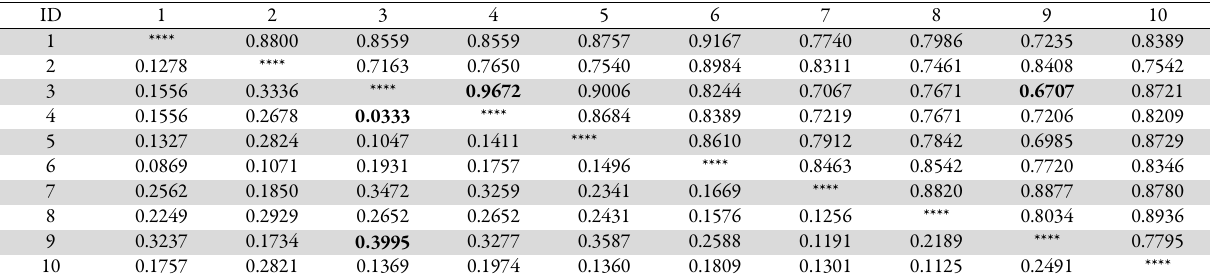
Table 5. Genetic identity (above diagonal) and genetic distance (below diagonal) values among of 10 gamma radiation treatments in potato cvs. ‘Valor’ and ‘Spunta’